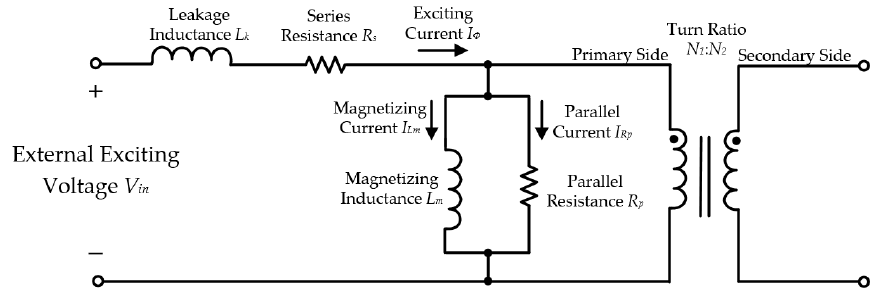
Figure 1. The open circuit of the transformer